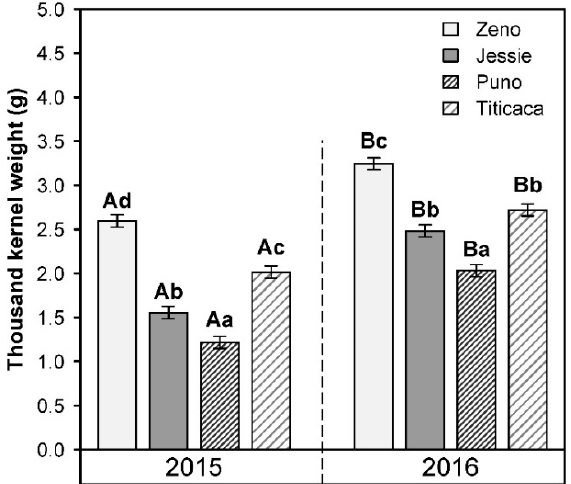
Figure 3. Thousand kernel weight (g) for the two years and four quinoa cultivars (Zeno, Jessie, Puno, Titicaca). Within year, bars headed by the same lowercase letter are not significantly different ( p < 0.05). Capital letters compare the two years for the same cultivar, bars headed by the same letter are not significantly different ( p < 0.05). Error bars indicate the standard error of the mean.